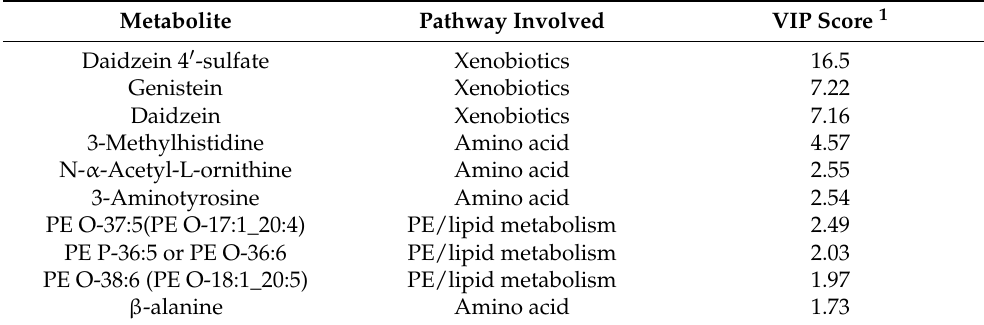
Table 3. Top 10 metabolites with the highest variable importance in projection (VIP) 1